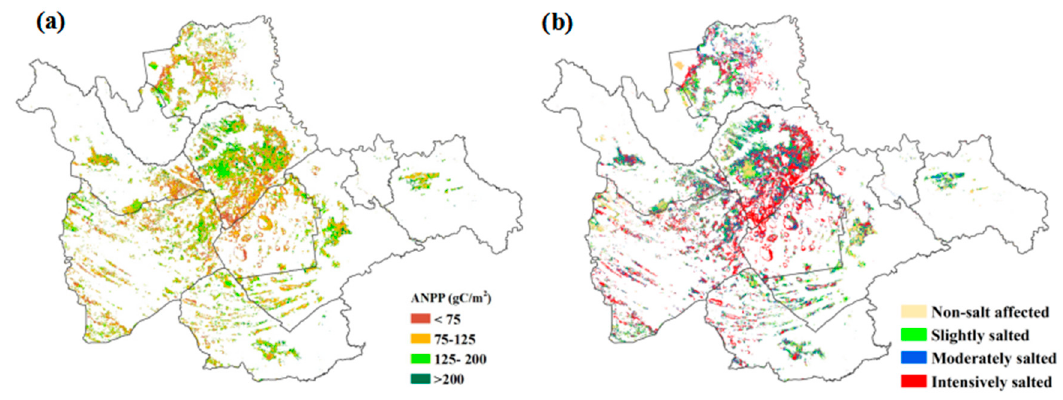
Figure 7. Spatial distribution of EC and ANPP in the West Jilin. ( a ) the spatial distribution of ANPP; ( b ) the spatial distribution of soil salinity.